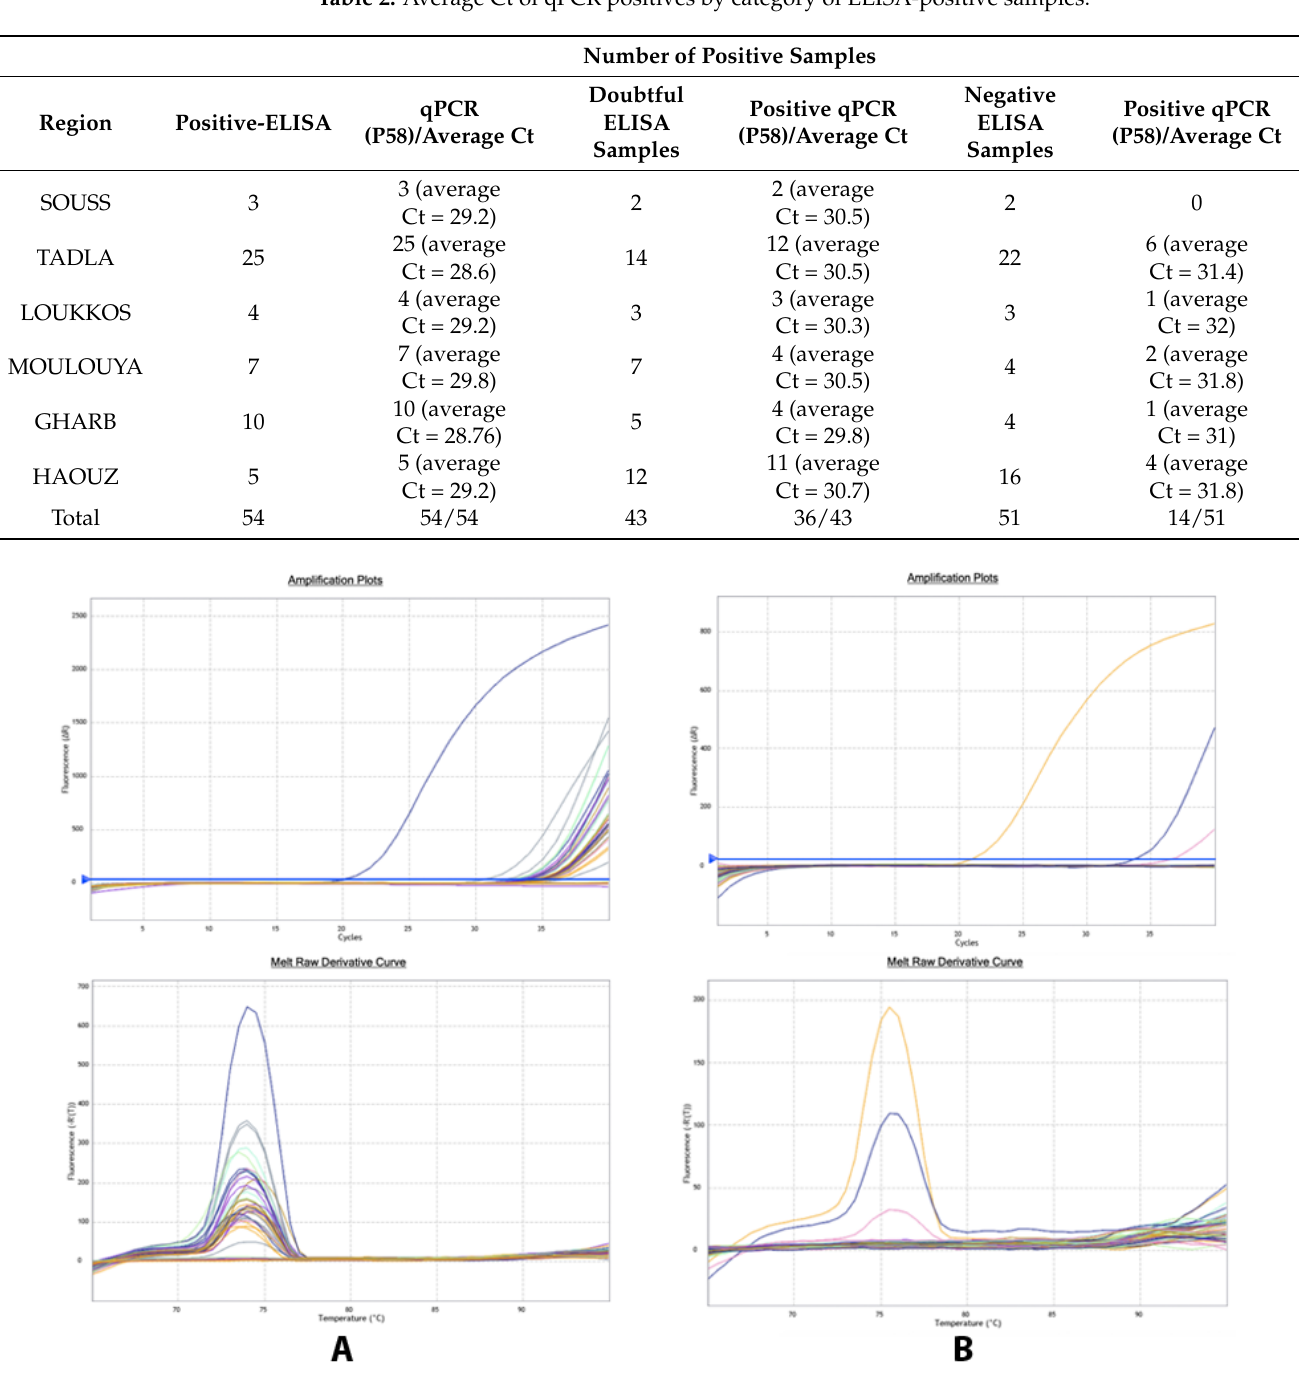
Figure 4. qPCR for Spiroplasma citri detection. Amplification plot and melt peak analysis